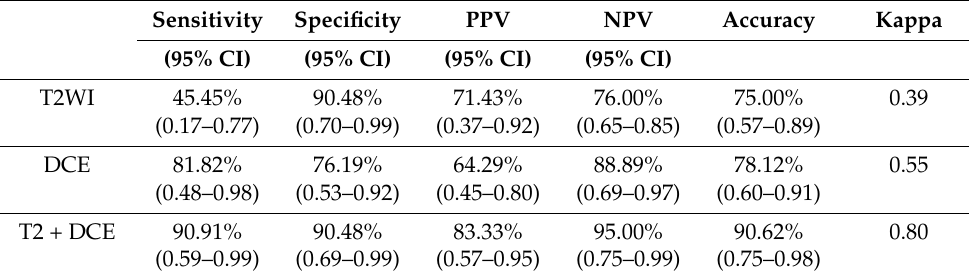
Table 3. Performance of the MRI sequences in determining the depth of myometrial invasion. Sensitivity Specificity PPV NPV